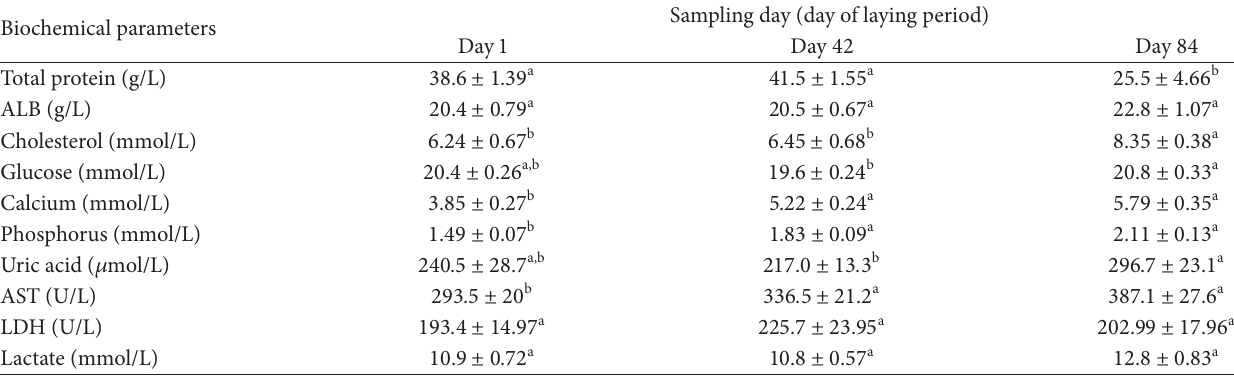
Table 2: Selected biochemical parameters in pheasant hens ( 𝑛 = 15 /group) housed in an enhanced cage system during the laying period (means ±